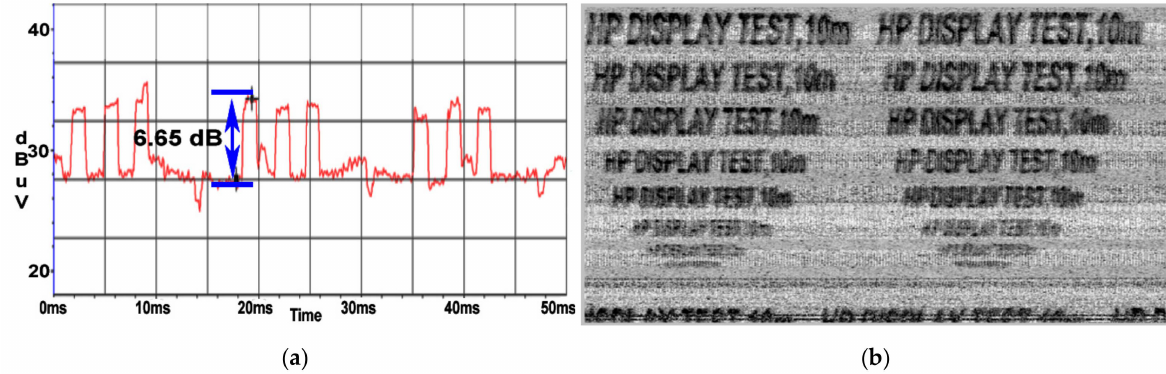
Figure 17. HP display: ( a ) SNR measured at a distance of 10 m; ( b ) Image recovered at a distance of 10